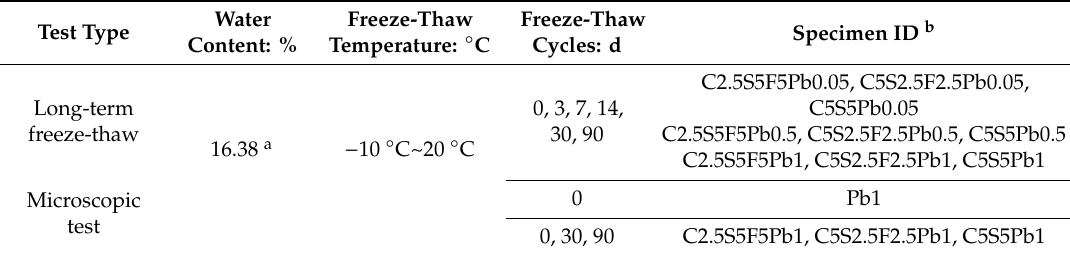
Table 3. Table of orthogonal design experiment